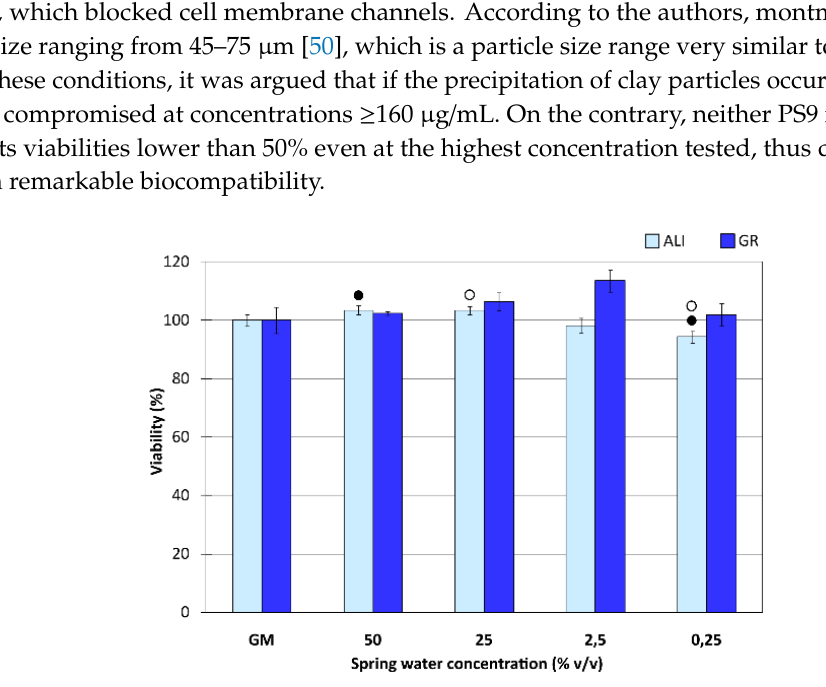
Figure 3. Biocompatibility tests (contact time 24 h) of ALI and GR medicinal waters. Viability (%) vs. medicinal water concentration (% v/v ) toward NHDF. GM stands for “growth medium” and refers to control test. Mean values ± s.d.; n = 8. Significant differences are marked as (●) ALI 50% ( v/v ) vs. ALI 0.25% ( v/v ); ( ○ ) ALI 25% ( v/v ) vs. ALI 0.25% ( v/v ). Mann–Whitney (Wilcoxon) W tests, p values ≤ 0.05.